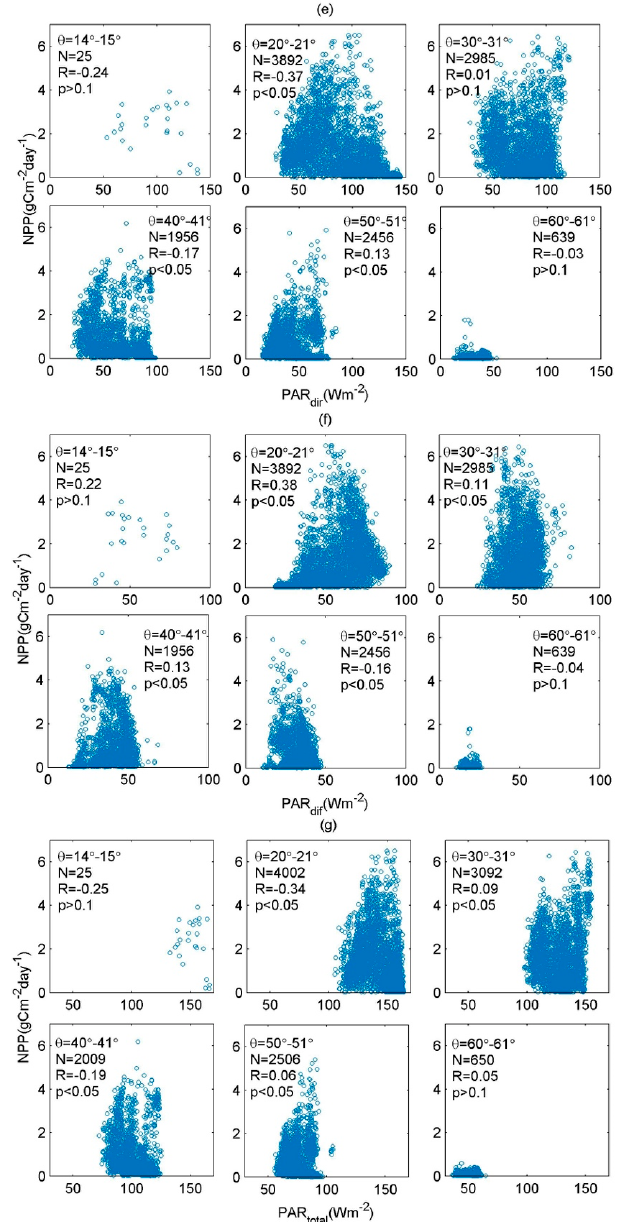
Figure 7. Scatterplots of ( a ) AOD and PAR dir ( b ) AOD and PAR dif ( c ) AOD and PAR total ( d ) AOD and NPP ( e ) PAR dir and NPP ( f ) PAR dif and NPP ( g ) PAR total and NPP for six solar zenith angles (14°–15°,